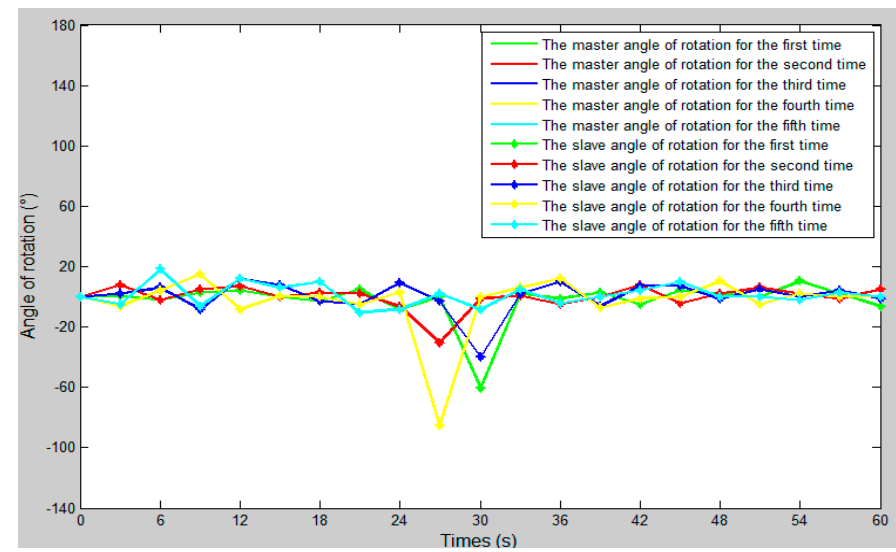
Figure 18. The comparison curve between the slave angle of rotation and the master angle of rotation.